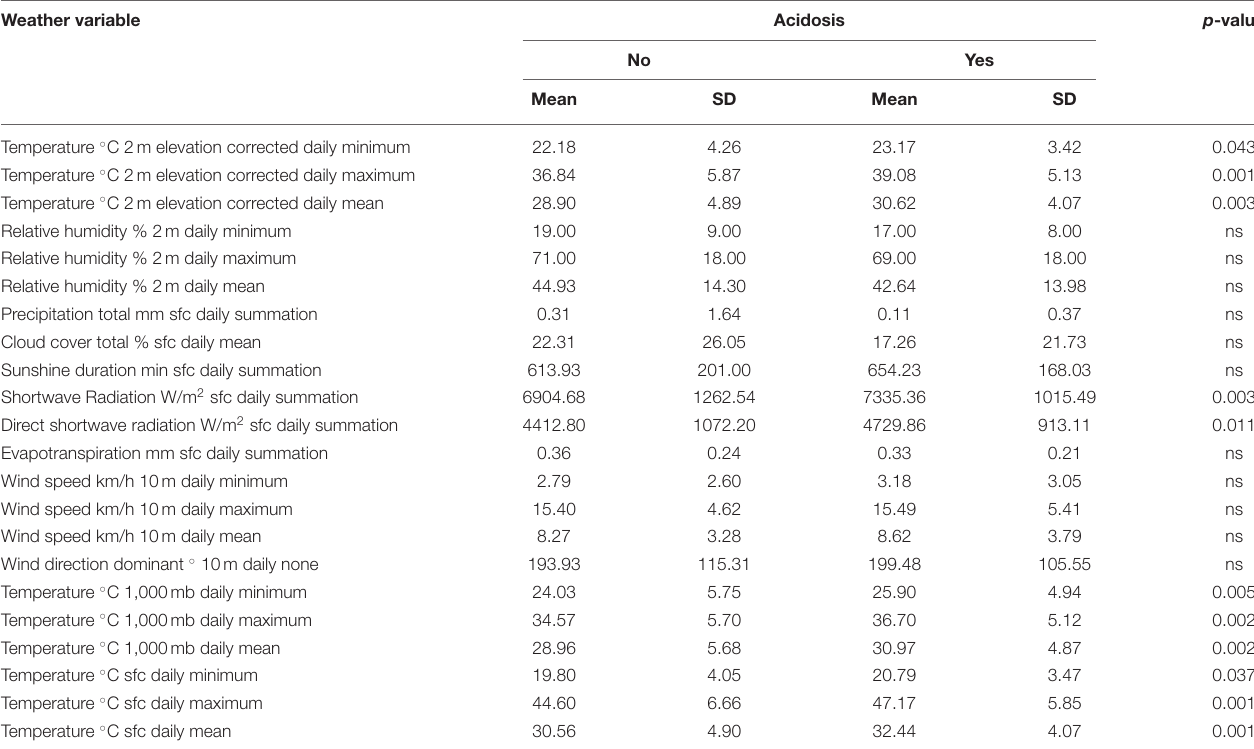
TABLE 3E | Difference in day-of-admission weather variables in Dubai City between COVID-19 patients’ clinical outcomes: Acidosis. Weather variable